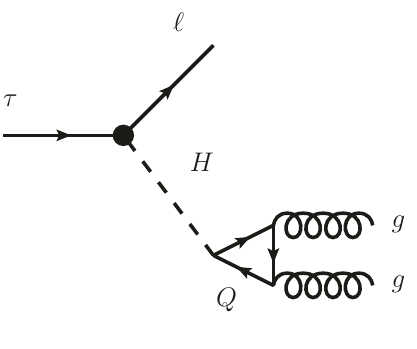
Figure 2 . Dominant scalar contribution to τ → ‘PP , with ‘ = e, µ and P = π, K . The dot indicates the CLFV vertex. The Q in the loop stands for a heavy quark, namely Q = c, b, t